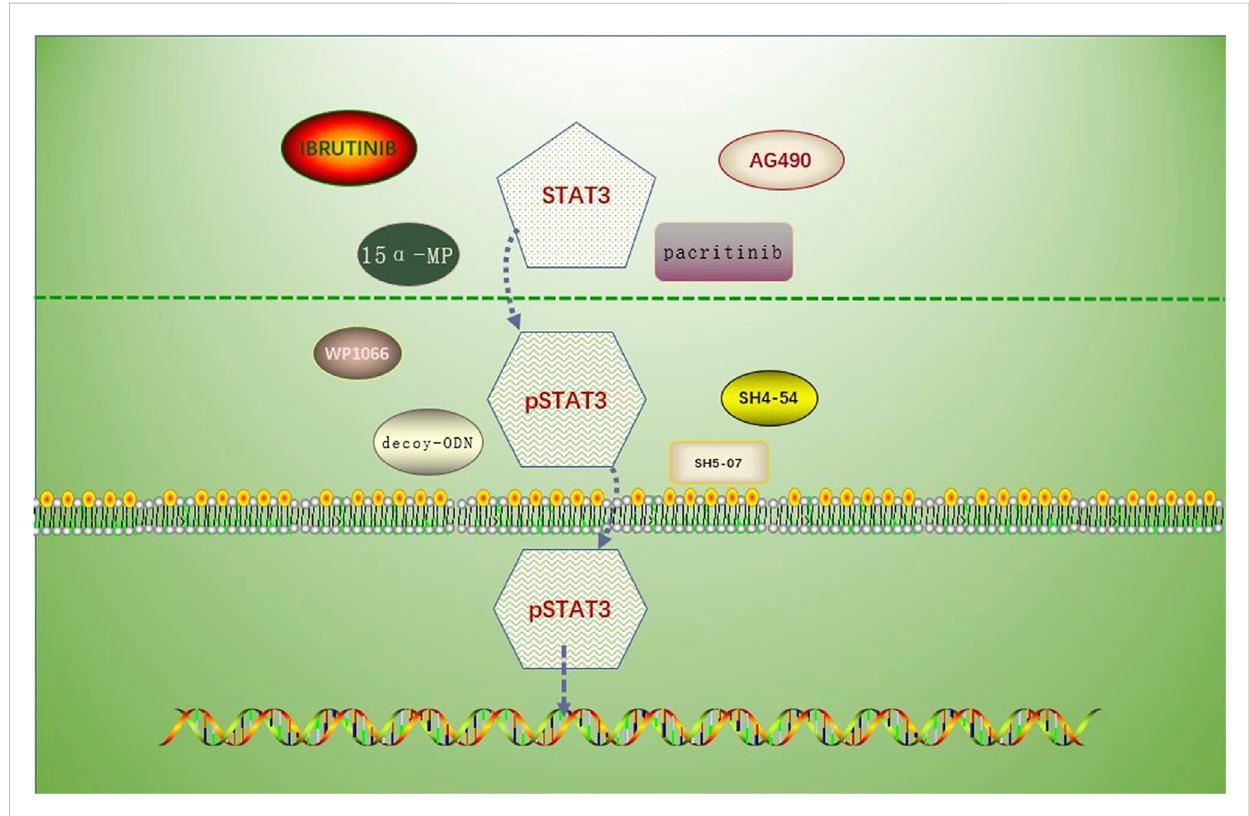
FIGURE 2 Drug mechanism involving the prevention of STAT3 phosphorylation or inhibition of p-STAT3 nuclear translocation. Drugs associated with the inhibition of STAT3 phosphorylation: AG490, MNS1 Leu and MNS1 MV, pacritinib, 15 α - MP; drugs associated with the inhibition of STAT3 nuclear translocation: SH5-07 and SH4-54, and